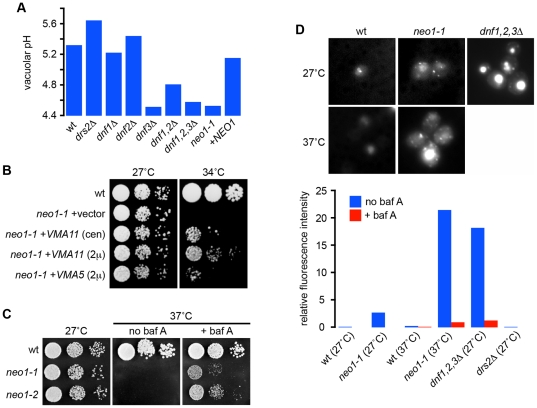
P4-ATPase flippases contribute to vacuole pH regulation.(a) Vacuolar pH is defective in P4-ATPase mutants. Vacuolar pH was measured in wild type BY4742 cells, strains lacking one or more of the P4-ATPases (drs2Δ, dnf1Δ, dnf2Δ, dnf3Δ) or with a temperature sensitive allele of the essential NEO1 gene (neo1-1) without or with (+NEO1) a plasmid containing wild type NEO1. The neo1 strains were shifted to the nonpermisive temperature for 1 hour (34°C). Data represent average of duplicates and one of three independent experiments. (b) Overexpression of VMA genes suppresses the neo1-1 mutant growth defect. The neo1-1 strain was transformed with an empty vector, a single copy VMA11, a multi-copy VMA11, or multi-copy VMA5 plasmids. Serial dilutions of the transformants were spotted on YPD plates and tested at 27°C and 34°C. (c) Inhibition of V-ATPase function suppresses neo1-ts growth defect at nonpermissive temperature. Serial dilution of wild type or two neo1-ts mutant cultures were tested on YPD plates containing 5 µM bafilomycin A1. (d) Compartmental hyperacidification in neo1-1 or triple dnf1,2,3Δ mutants. Micrographs show quinacrine staining of wild type (wt), neo1-1 or dnf1,2,3Δ triple mutants at permissive (27°C) and nonpermissive (37°C) temperatures. Fluorescence intensity (a.u., arbitrary units) was quantified by flow cytometry in the absence or presence of 5 µM bafilomycin A1 (baf A). Negative controls include drs2Δ cells. 30,000 cells were analyzed for each strain.